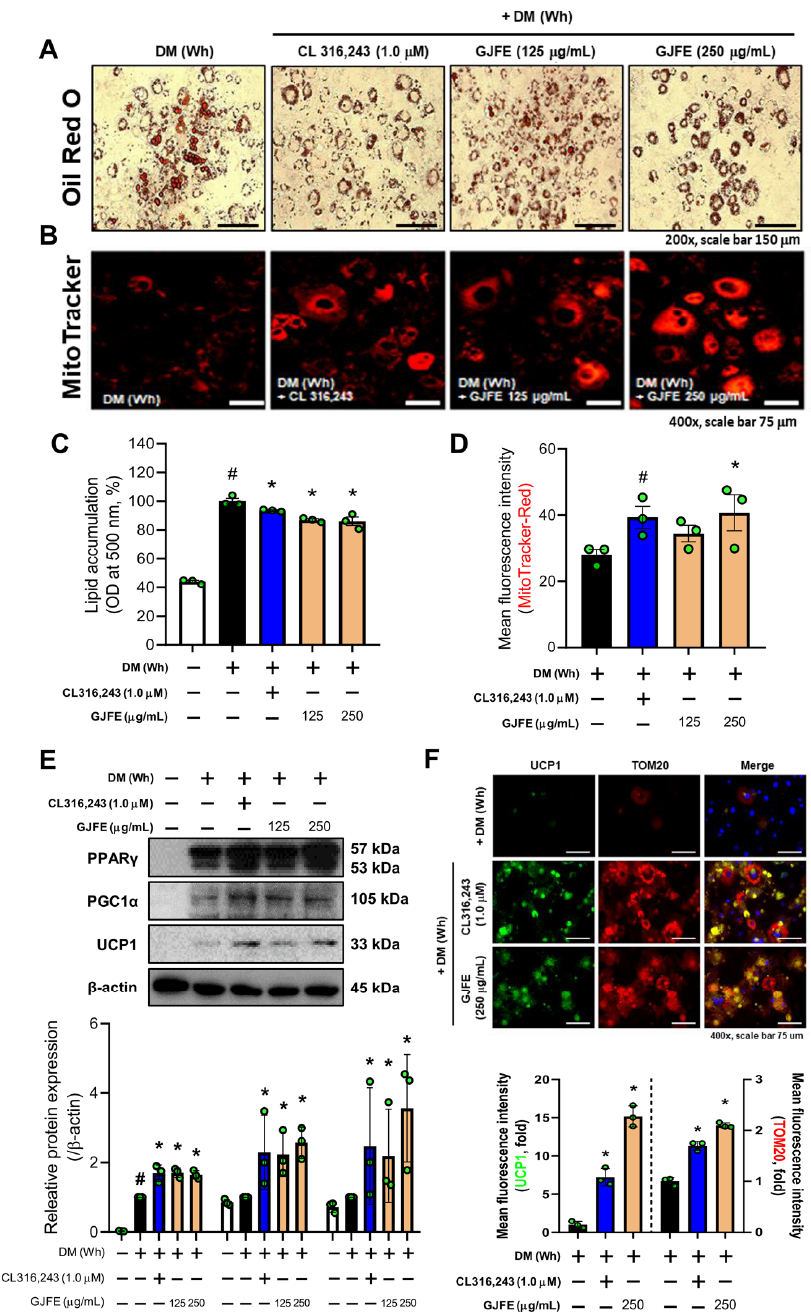
Figure 2. Effect of GJFE on beige trans-differentiation of white-induced 3T3-L1 cells. ( A ) Intracellular lipid droplets were stained with Oil Red O (magnification 400 × , scale bar 75 µ m), and ( C ) the absorbance was detected at 500 nm in white-induced 3T3-L1 cells treated with GJFE (125 and 250 µ g/mL) or CL316,243 (1.0 µ M) ( β 3-AR agonist). ( B , D ) Mitochondrial abundance was obtained by MitoTracker Red staining (magnification 400 × , scale bar 75 µ m). ( E ) Protein levels of PPAR γ , PGC1 α , and UCP1 were analyzed by Western blot analysis. ( F ) The expression of UCP1 (green), TOM20 (red), and DAPI (blue) were detected by immunofluorescence staining (magnification 400 × , scale bar 75 µ m). β -actin was used as a loading control for Western blot analysis. All data are expressed as the mean ± SEM of the data from three or more separate experiments. # p < 0.05 vs. DM (Wh)-untreated 3T3-L1 cells, * p < 0.05 vs. DM (Wh)-treated 3T3-L1 cells. GJFE, Gardenia jasminoides fruit